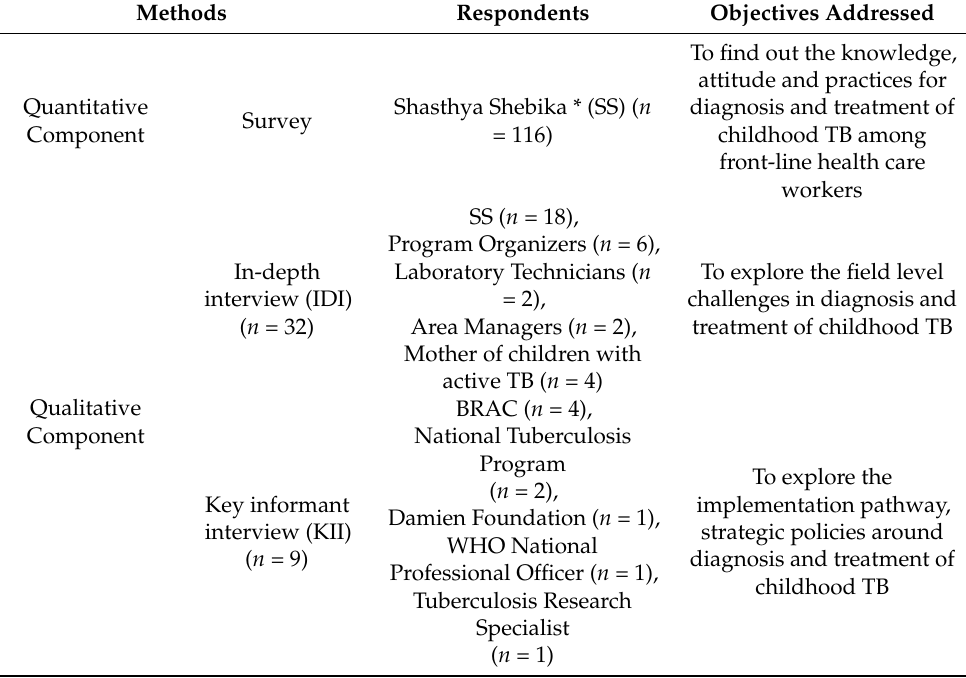
Table 1. Summary of the methods and